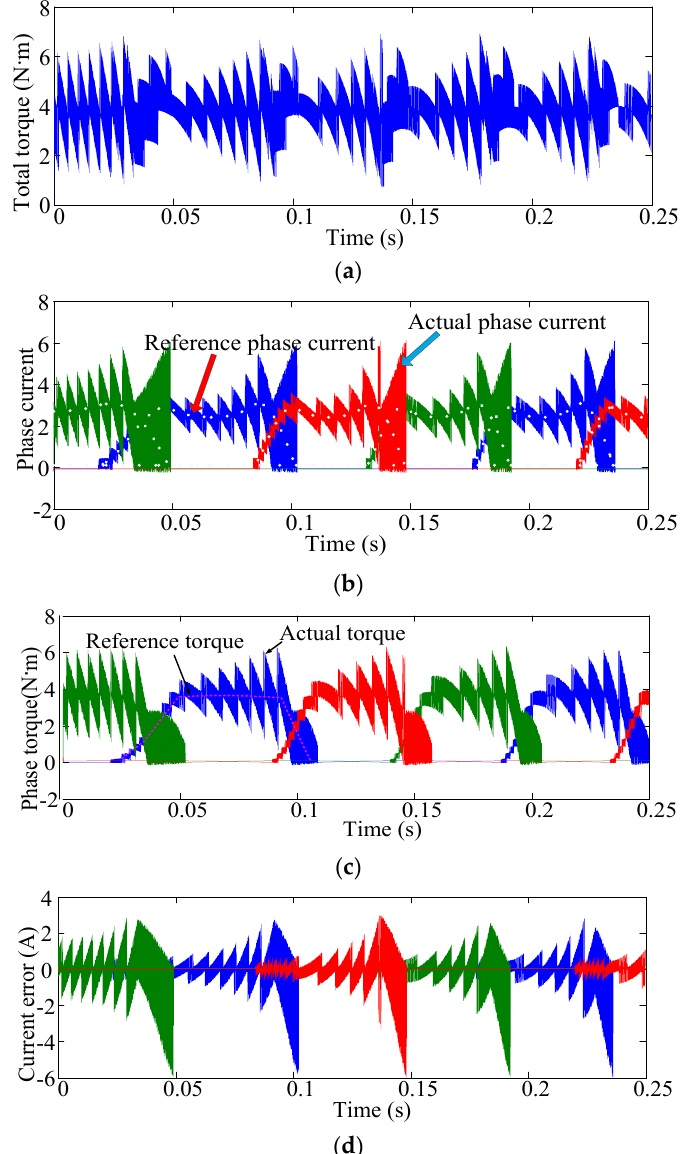
Figure 8. Simulation result when with current chopping control (CCC) method based on cube TSF (band is set 0.1, reference torque is set 3.7 N · m and sample time is set 100 µs). ( a ) Profiles of phase current and its reference ( b ) Total torque ( c ) Phase torque ( d ) Phase current error.